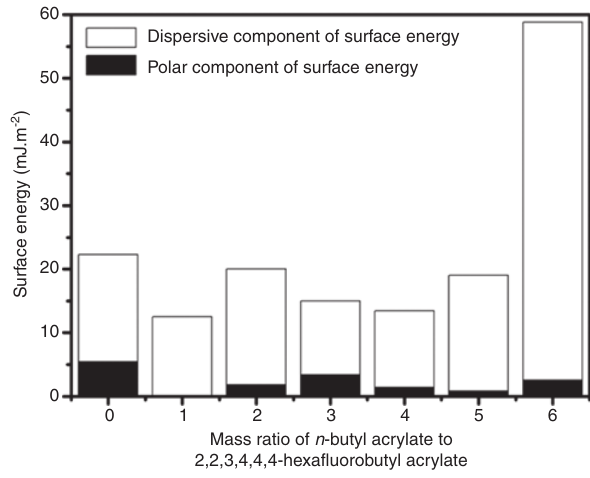
Figure 5: Effect of monomer ratio on the surface energies of the